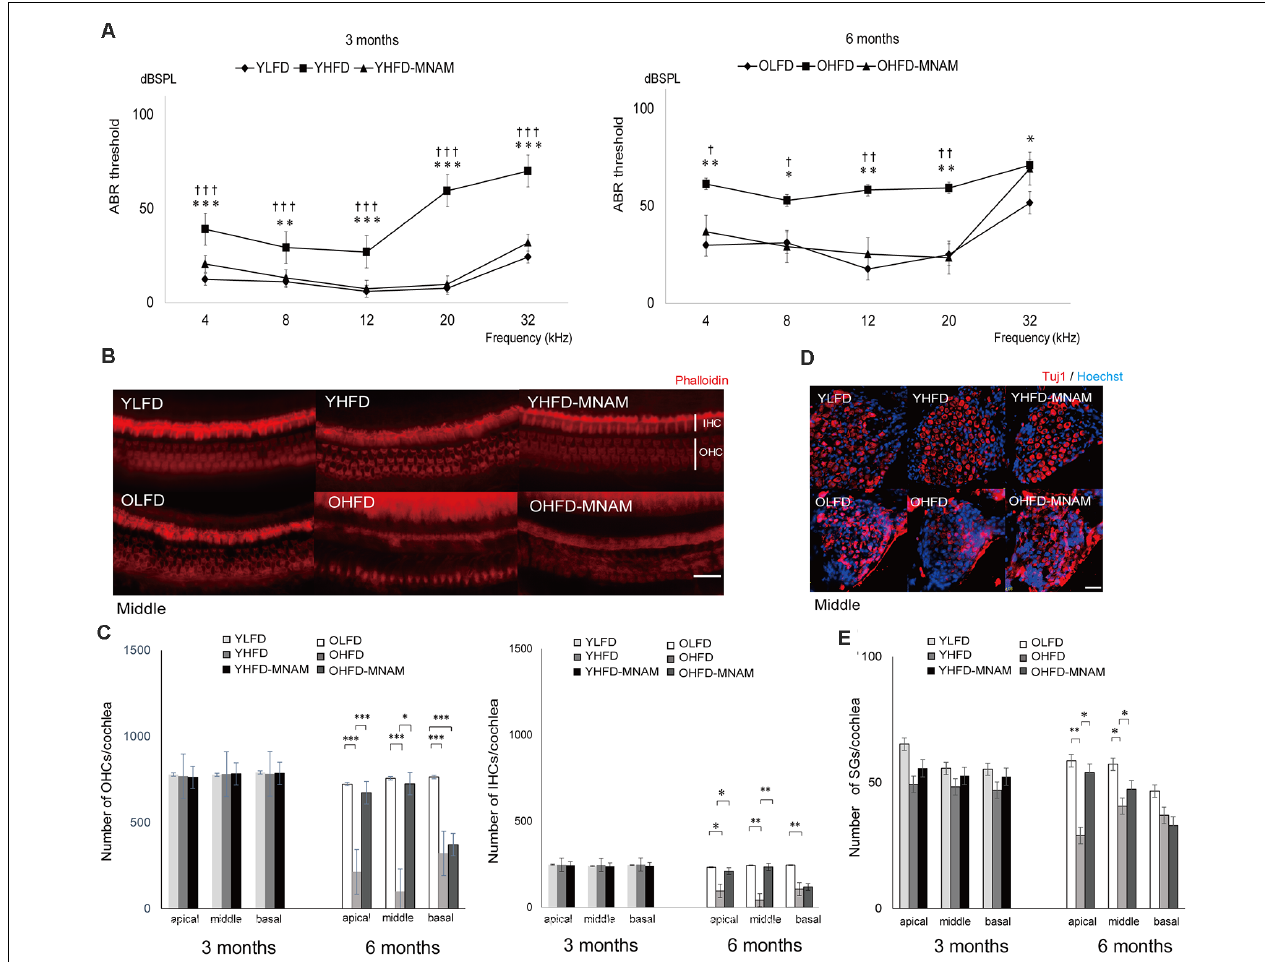
FIGURE 3 | The onset of age-related hearing loss (ARHL) and effect of MNAM supplementation on ARHL: developmental changes in auditory thresholds, hair cell counts, and spiral ganglion cell counts in the three tested mice groups. (A) The ABR recording results at 3 and 6 months after commencement of the experiment. All groups developed age-related hearing loss at 6 months, rather than at 3 months (YLFD: p = at 4 kHz, p = at 8 kHz, p = at 12 kHz, p = at 20 kHz, and p = at 32 kHz, YHFD: p = at 4 kHz, p = at 8 kHz, p = at 12 kHz, p = at 20 kHz, and p = at 32 kHz, YHFD-MNAM: p = at 4 kHz, p = at 8 kHz, p = at 12 kHz, p = at 20 kHz, and p = at 32 kHz). The YHFD and OHFD developed severe hearing loss compared with the YLFD and OLFD mice (YHFD vs. YLFD: p < 0.001 at 4 kHz, p = 0.006 at 8 kHz, p < 0.001 at 12 kHz, p < 0.001 at 20 kHz, and p < 0.001 at 32 kHz, OHFD vs. OLFD: p = 0.003 at 4 kHz, p = 0.01 at 8 kHz, p = 0.003 at 12 kHz, p = 0.003 at 20 kHz, and p = 0.03 at 32 kHz). All groups, n = 5, ∗ p < 0.05, ∗∗ p < 0.01, ∗∗∗ p < 0.001. In the YHFD-MNAM and OHFD-MNAM groups, hearing loss was prevented markedly compared with the YHFD and YLFD groups (YHFD-MNAM vs. YLFD-MNAM: p < 0.001 at 4 kHz, p = 0.004 at 8 kHz, p < 0.001 at 12 kHz, p < 0.001 at 20 kHz, and p < 0.001 at 32 kHz, OHFD-MNAM vs. OLFD: p = 0.01 at 4 kHz, p = 0.04 at 8 kHz, p = 0.006 at 12 kHz, p = 0.005 at 20 kHz, and p = 0.40 at 32 kHz). All groups, n = 5, † p < 0.05, †† p < 0.01, ††† p < 0.001. (B) Phalloidin-staining of the HCs in a surface preparation in the middle turn at 3 and 6 months after experiment initiation. The OHFD mice developed greater OHC and IHC loss than the other two groups. The OHFD-MNAM mice exhibited lower OHC and IHC loss compared with the OHFD mice. (C) The OHC and IHC counts in all turns at 3 and 6 months after commencement of the experiment. The YHFD mice did not develop OHC and IHC loss, compared to the other two groups (YLFD; OHC: p = 0.10 at apical, p = 0.09 in the middle, p = 0.13 at basal, IHC: p = 0.78 at apical, p = 0.61 in the middle, p = 0.43 at basal, YHFD-MNAM; OHC: p = 0.63 at apical, p = 0.10 in the middle, p = 0.62 at basal, IHC: p = 0.34 at apical, p = 0.23 in the middle, p = 0.41 at basal). The OHFD mice developed greater OHC and IHC loss than the other two groups (OLFD; OHC: p < 0.001 in all turns, IHC: p = 0.04 at apical, p = 0.008 in the middle, p = 0.002 at basal, OHFD-MNAM mice; OHC: p < 0.001 at apical, p = 0.01 in the middle, p = 0.67 at basal, IHC: p = 0.04 at apical, p = 0.009 in the middle, p = 0.29 at basal). All groups, n = 5, ∗ p < 0.05, ∗∗ p < 0.01, ∗∗∗ p < 0.001. (D) The immunostaining of the SGCs using the anti-Tuj1 antibody in the middle turn at 3 and 6 months after commencement of the experiment. The OHFD mice developed greater SGC loss than the other two groups. The OHFD-MNAM mice exhibited lower SGC loss compared with the OHFD mice. (E) The SGC counts in all turns at 3 and 6 months after commencement of the experiment. There were no significant differences in SGC numbers between YLFD and YHFD ( p = 0.09 at apical, p = 0.28 in the middle, p = 0.10 at basal), and between YHFD and YHFD-MNAM mice ( p = 0.31 at apical, p = 0.30 in the middle, p = 0.07 at basal). The OHFD mice developed greater SGC loss than the OLFD mice, except for the basal turn ( p = 0.002 at apical, p = 0.03 in the middle, p = 0.07 at basal). The OHFD-MNAM mice exhibited less SGC loss than the OHFD mice ( p = 0.01 at apical, p = 0.01 in the middle, p = 0.21 at basal). All groups, n = 5, ∗ p < 0.05, ∗∗ p < 0.01, ∗∗∗ p < 0.001 (Bars: 100 µ m; YLFD, low-fat diet-fed 3-month-old mice; OLFD, low-fat diet-fed 6-month-old mice; YHFD, high-fat diet-fed 3-month-old mice; OHFD, high-fat diet-fed 6-month-old mice; YHFD-MNAM, high-fat diet plus 1% N 1 -methylnicotinamide-fed 3-month-old mice; OHFD-MNAM, high-fat diet plus 1% N 1 -methylnicotinamide-fed 6-month-old mice; OHCs, outer hair cells; IHCs, inner hair cells; SGCs, spiral ganglion cells; anti-Tuj1, anti-beta III